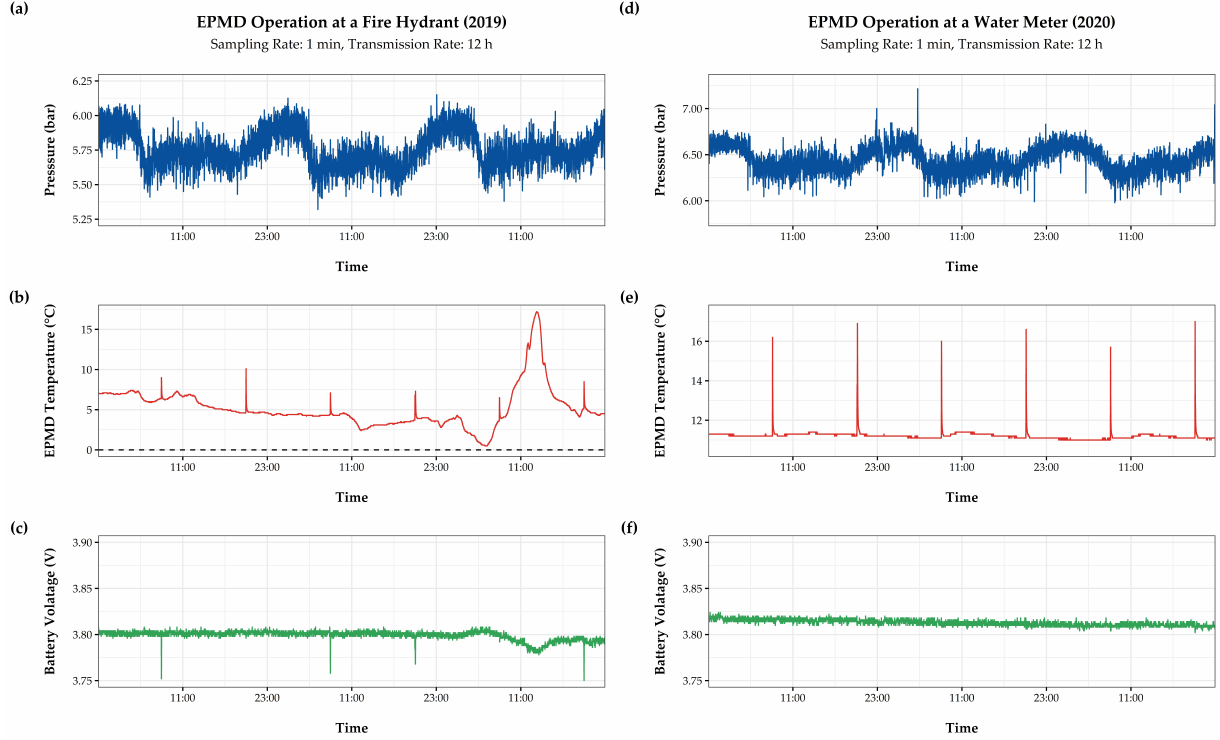
Figure 2. Snapshots from long-term field-testing of the EPMD at a fire hydrant ( a – c ) and a water meter ( d – f